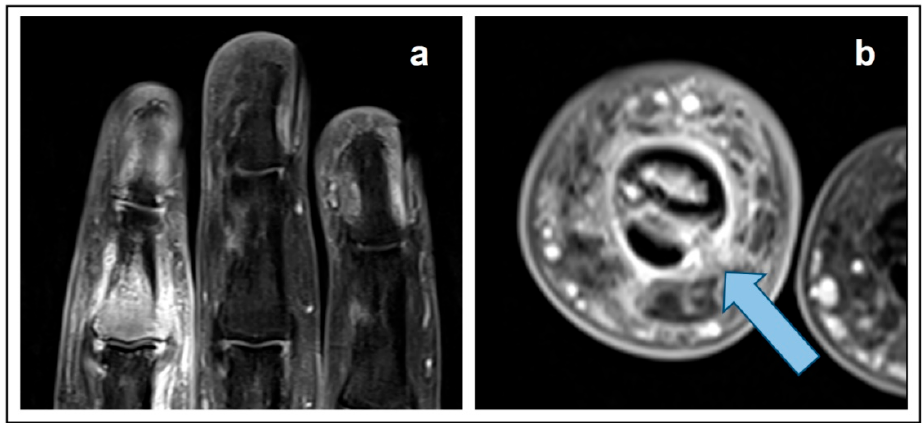
Figure 1. T1-weighted fat-saturated, contrast-enhanced MRI. ( a ) coronal view. ( b ) axial view. The patient stopped smoking 12 years ago (after 20-30 pack years); there was no pos- itive family history, no B symptoms (i.e., fever, night sweats, unintentional weight loss), occasional cough, no sputum, and no hemoptysis. Staging by positron emission tomogra- phy/computed tomography (PET/CT) with 316 MBq [ 18 F]FDG revealed a primary tumor in the upper lobe of the right lung (Figure 2a) and multiple lymph node, soft tissue, and bone metastases (Figure 2b); cranial MRI revealed a brain metastasis.